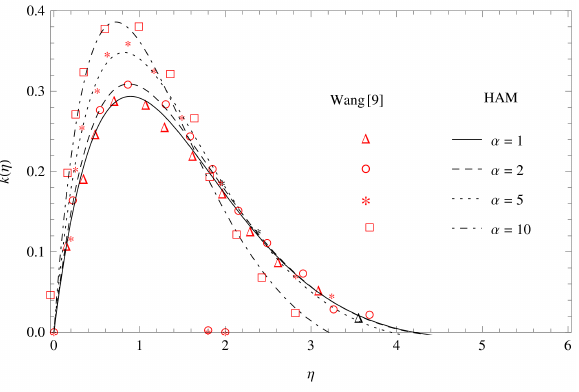
Fig. 30: Comparison of velocity profile k for Wang [9] and HAM solu-